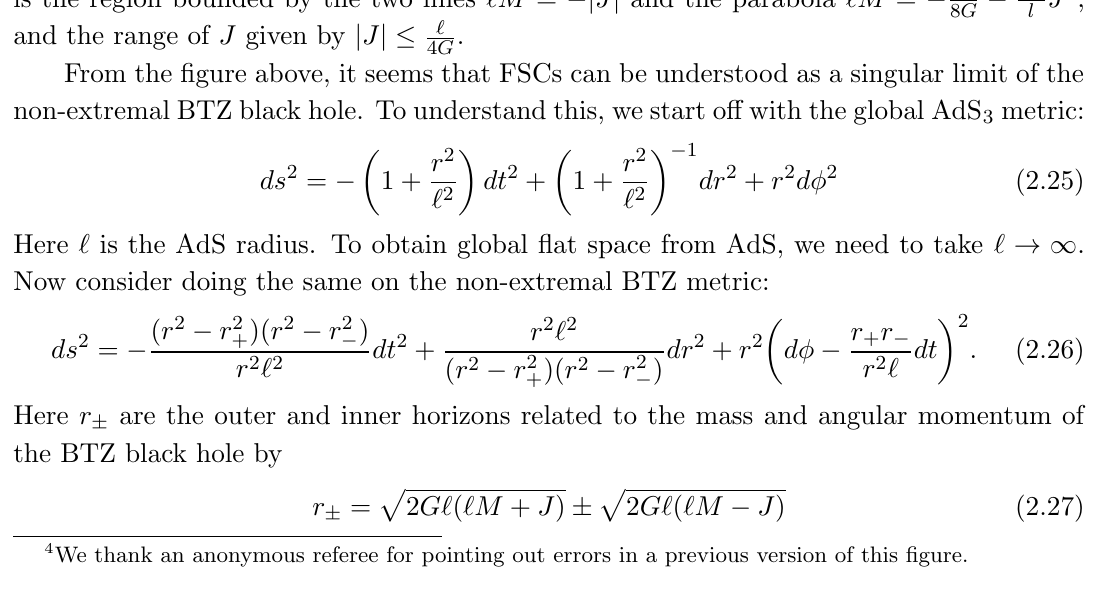
Figure 1 . Phase space of Einstein gravity in asymptotically (a) AdS Flat space